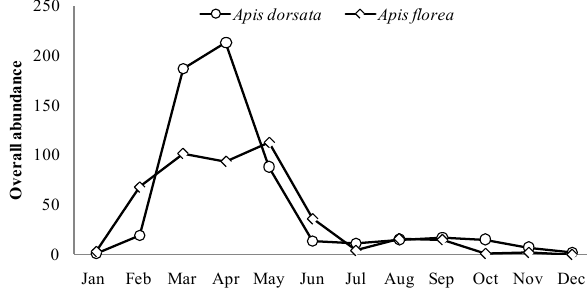
Fig 1 . Rank abundance curve based on population of A. dorsata and A. florea on 49 plant species at Bahauddin Zakariya University Campus, Multan, Pakistan during January to December, 2008. The seasonal dynamics revealed the peak activity of both Apis bees during early March to late May. Almost no activity was recorded in the months of November, December and January (Fig 2). Similarly, the maximum availability of floral resources (abundance of floral units and number of plant species in flowering) was also recorded in the spring season (March to May) followed by a gradual decline until December (Fig 3). Average monthly temperature and relative humidity is shown in Fig 4.